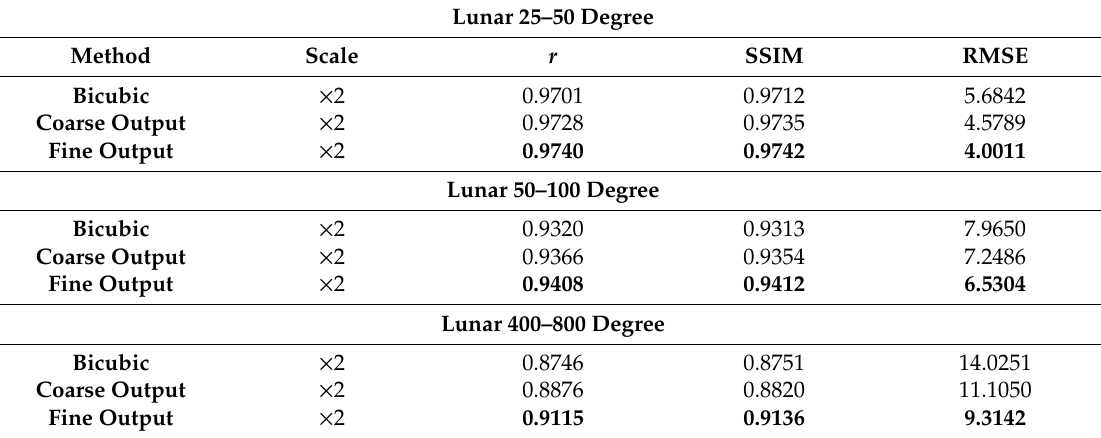
Table 2. Quantitative indicators of Experiment 1.